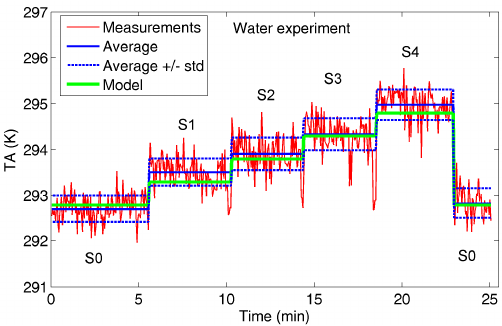
Figure 9. Water experiment: T A measured by radiometer (red and blue curves) and estimated by model (green curve).